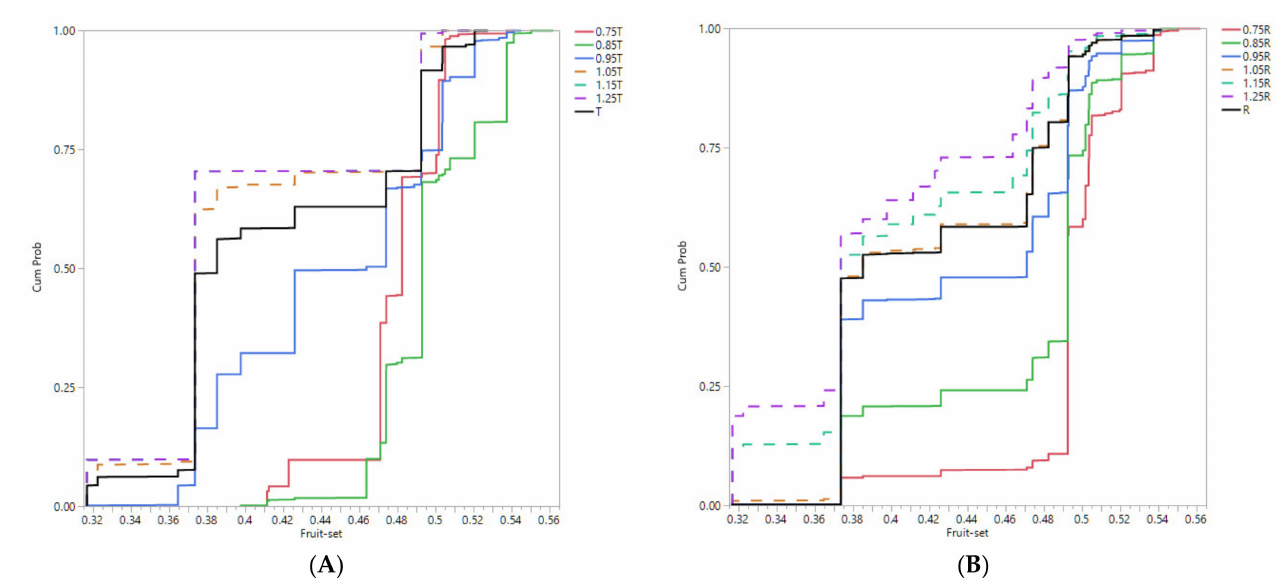
Figure A1. Cumulative probability of predicted fruit-set in the 151 bog blueberry production regions in Northeast China under potential future temperature ( A ) or precipitation ( B ) change. T and R denote the baseline scenario where no temperature (T) or precipitation (R) changes were applied to current conditions. Table A1. Correlations between latitude/longitude and bog blueberry fruit-set in the 151 regions in Northeast China with changes of air temperature from − 25% to 25% (Pearson’s product-moment correlation test) when the number of rainy days was kept the same as the baseline scenario. Bold and italic numbers indicate statistically significant correlations ( α = 0.05). 0.75T + R